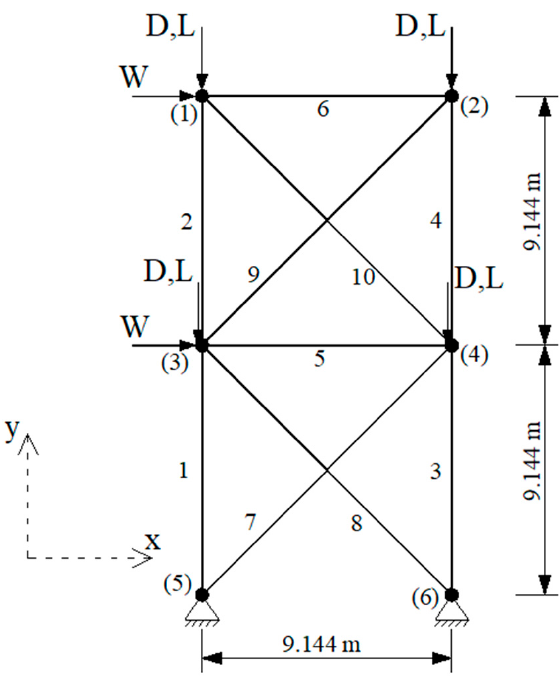
Figure 3. Layout and geometry of the 10-bar truss.